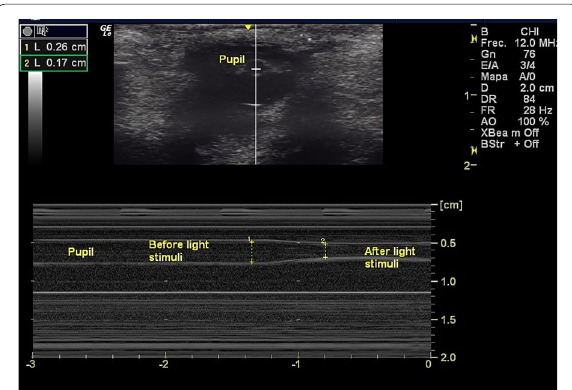
Fig. 2 Ocular ultrasound on 2D (top) and M-mode (bottom) showing pupil before light stimuli and after light stimuli. Pupillary on M-mode tracing is highlighted by two white, horizontal, straight, parallel lines